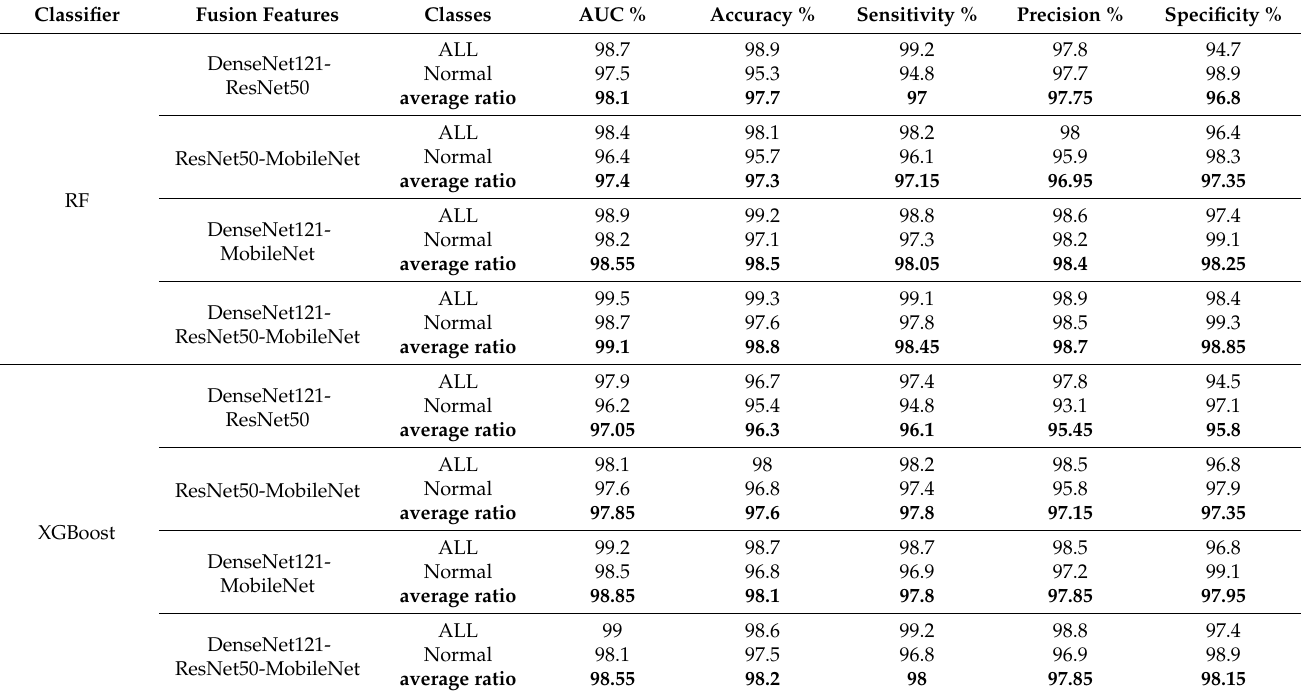
Table 7. Results of the RF and XGBoost classifiers based on fusion features of the CNN models of the C-NMC 2019 dataset for the diagnosis of acute